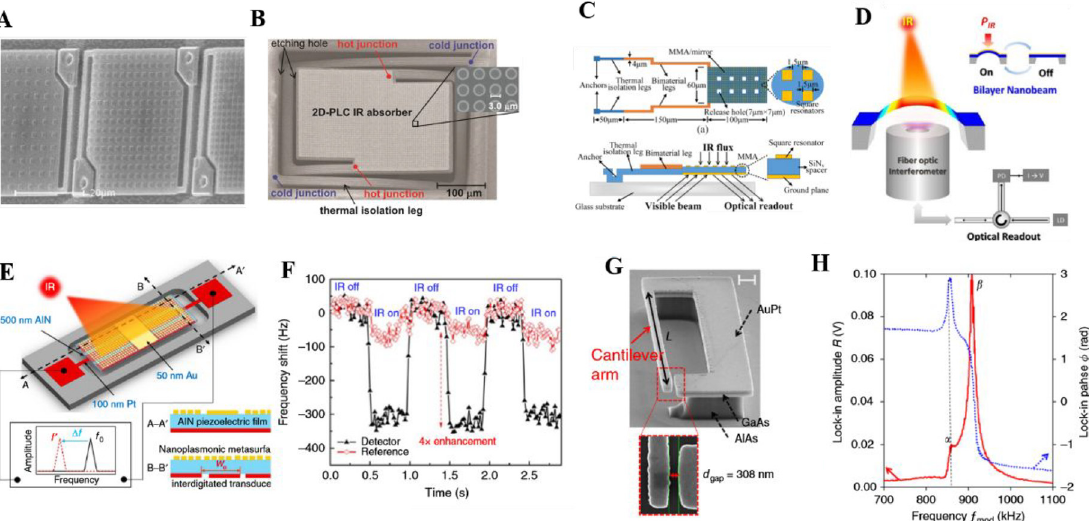
Figure10: MEMSradiationdetectorsininfraredandTHzrange,integratedwithmetamaterials(A)SEM imageof themicrobolometers withthe square MIM absorbers [131]. (B) SEM image of the thermopile with the two-dimensional plasmonic crystals [134]. (C) Schematic of the focal plane array with MIM absorbers [137]. (D). Schematic of nanobeam with nanoslit resonators [138]. (E) Schematic of the AlN piezoelectric resonator based IR detector and its (F) temporal response. The comparison with dummy resonator without metamaterials shows 4-fold enhancement [139]. (G) SEM image of the meta-atom: bilayer asymmetric SRR with GaAs and metal (H) Amplitude and phase response when the THz frequency is swept around the mechanical resonances α and β